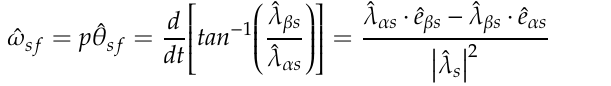
Figure 9. Rotor field-oriented control (RFOC) scheme.